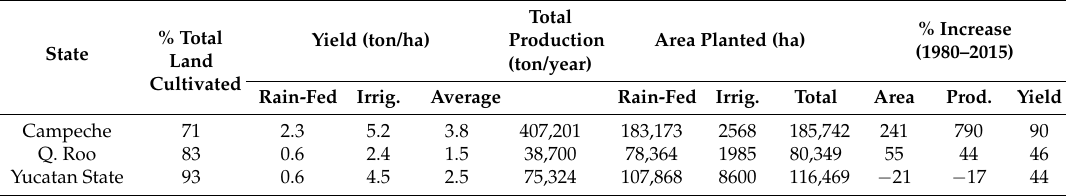
Table 1. Extent of maize, per hectare yield, and total production per state for 2015, both rain-fed and irrigated. Source of data: Agricultural and Fisheries Information Service (SIAP).